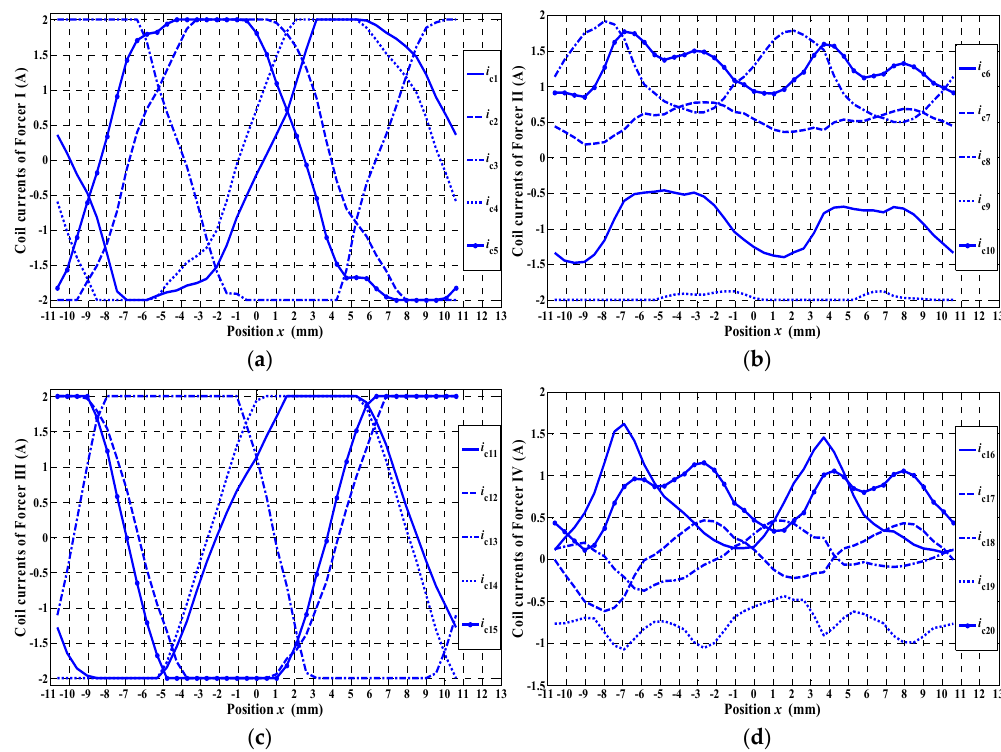
Figure 5. Coil currents of ( a ) Forcer I, ( b ) Forcer II, ( c ) Forcer III, and ( d ) Forcer IV by optimization commutation with boundary constraint I m = 2.0 A.